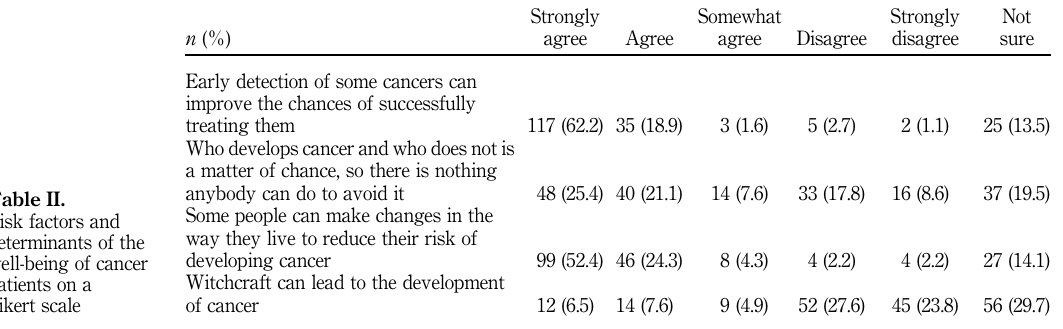
Table II. Risk factors and determinants of the well-being of cancer patients on a Likert